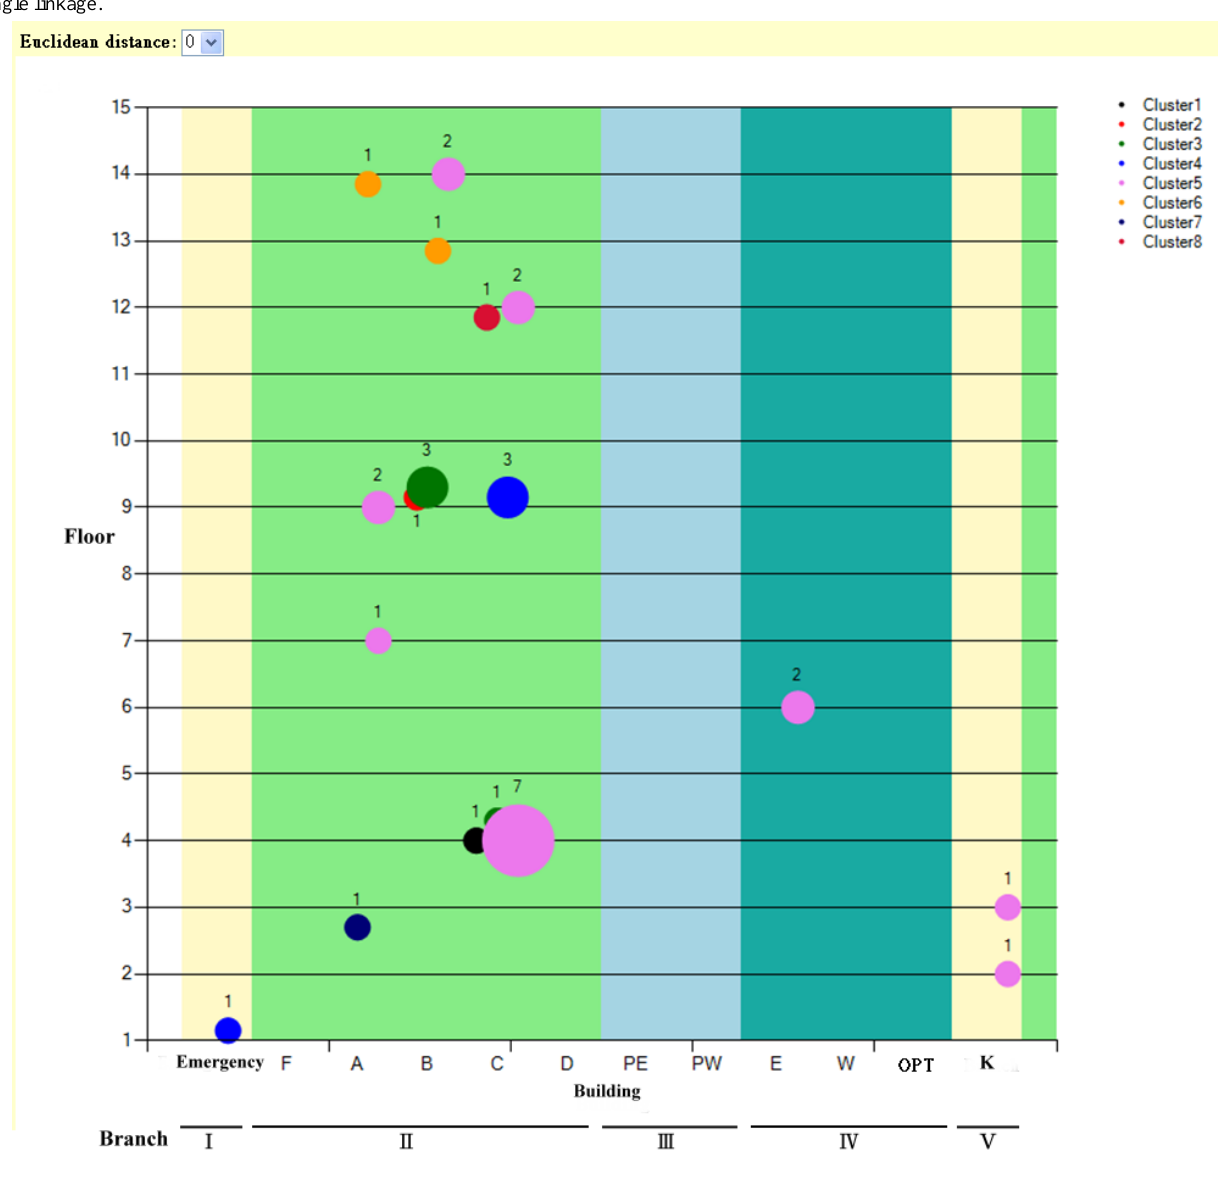
Figure 7. Bubble chart for visualization of the spatial distribution of MDRO clustering results. This chart display the spatial distribution of vancomycin-resistant Enterococcus faecium isolated from April 6, 2008, to April 26, 2008, and clustered with Euclidean distance equal to zero and single linkage.